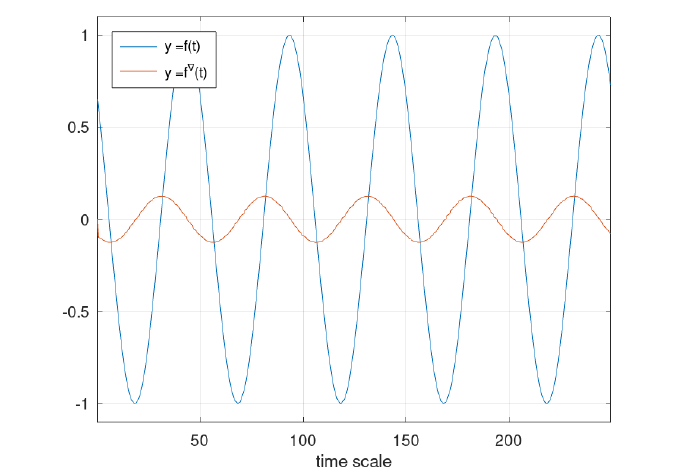
Figure 2. Nabla derivative of a sinusoidal